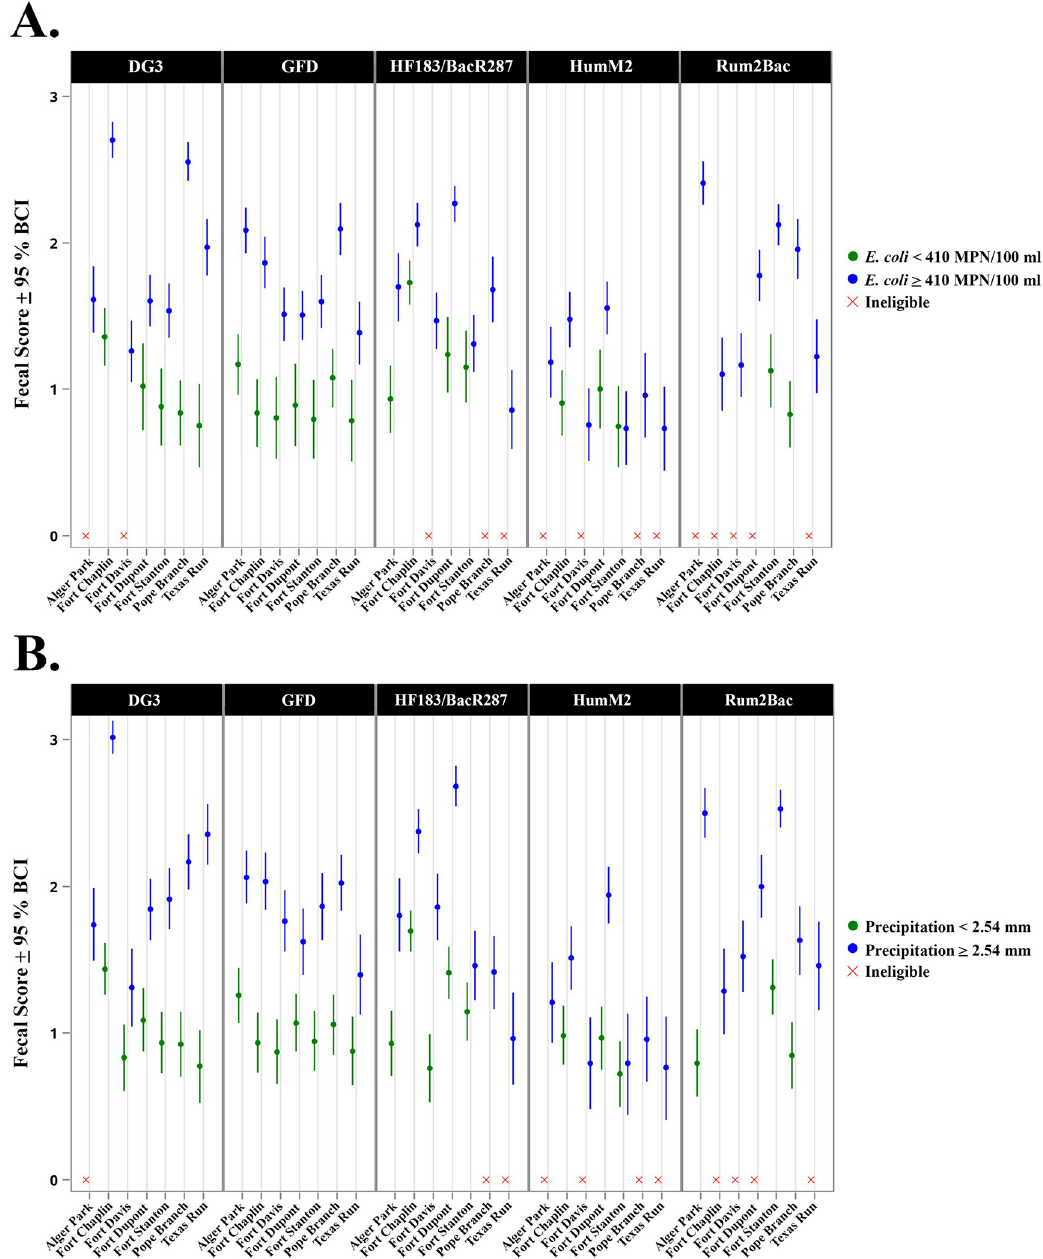
Fig 6. Host-associated genetic marker fecal scores (log 10 copies per 100 ml with 95% BCI) for each site using E . coli . (Panel A; threshold: � 410 MPN/100 ml) and precipitation (Panel B; threshold: � 2.54 mm) sample group definitions. An ‘X’ denotes that a sample grouping was ineligible for fecal score